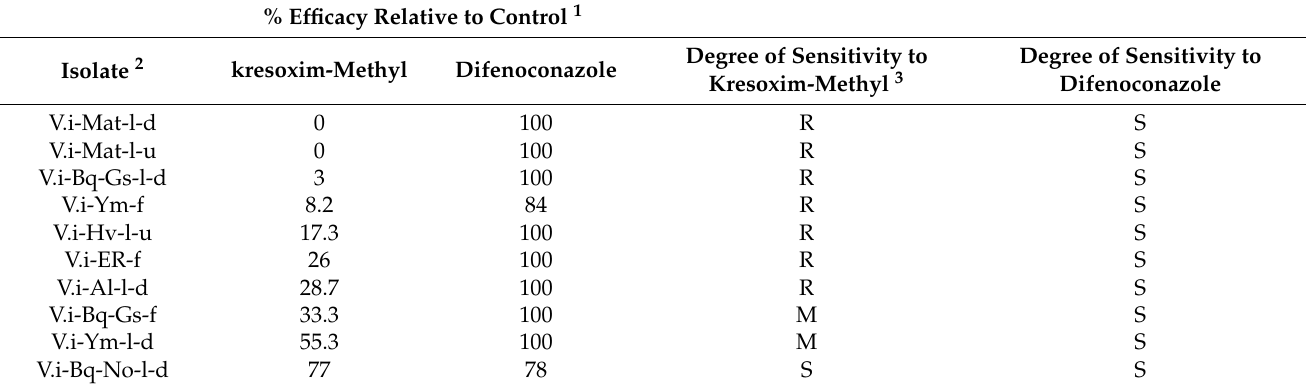
Table 5. Sensitivity of mycelia of ten Venturia inaequalis isolates to kresoxim-methyl and difenoconazole. % Efficacy Relative to Control 1 Isolate